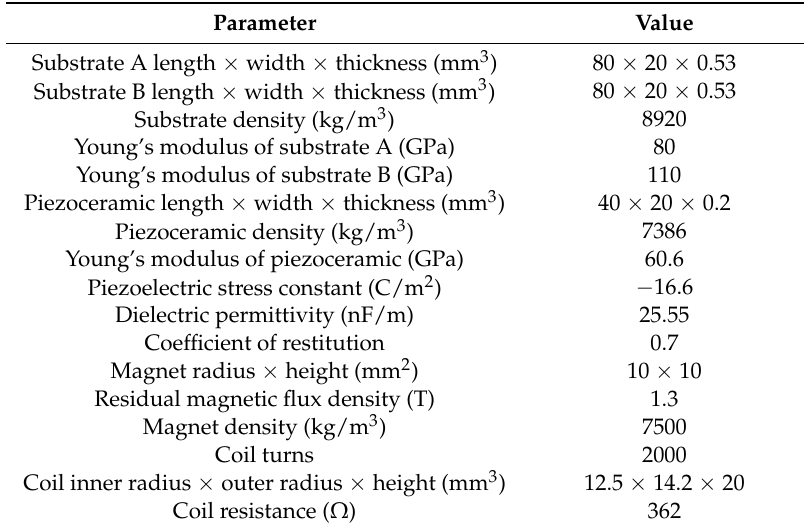
Table 1. Geometric and material parameters of the